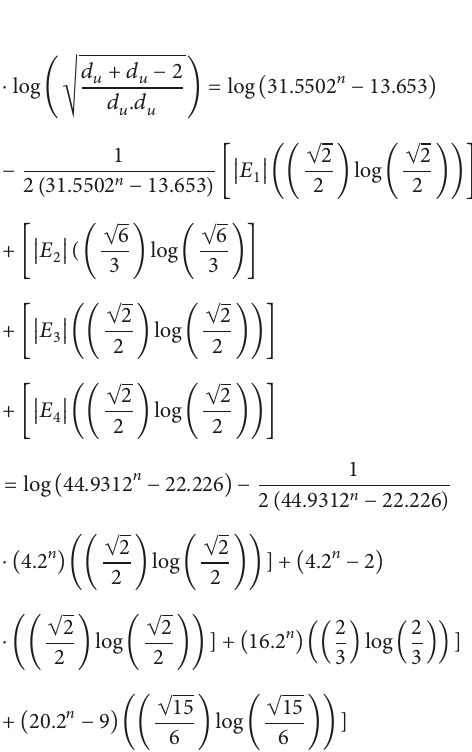
Figure 4: Poly(EThyleneAmidoAmine dendrimer.